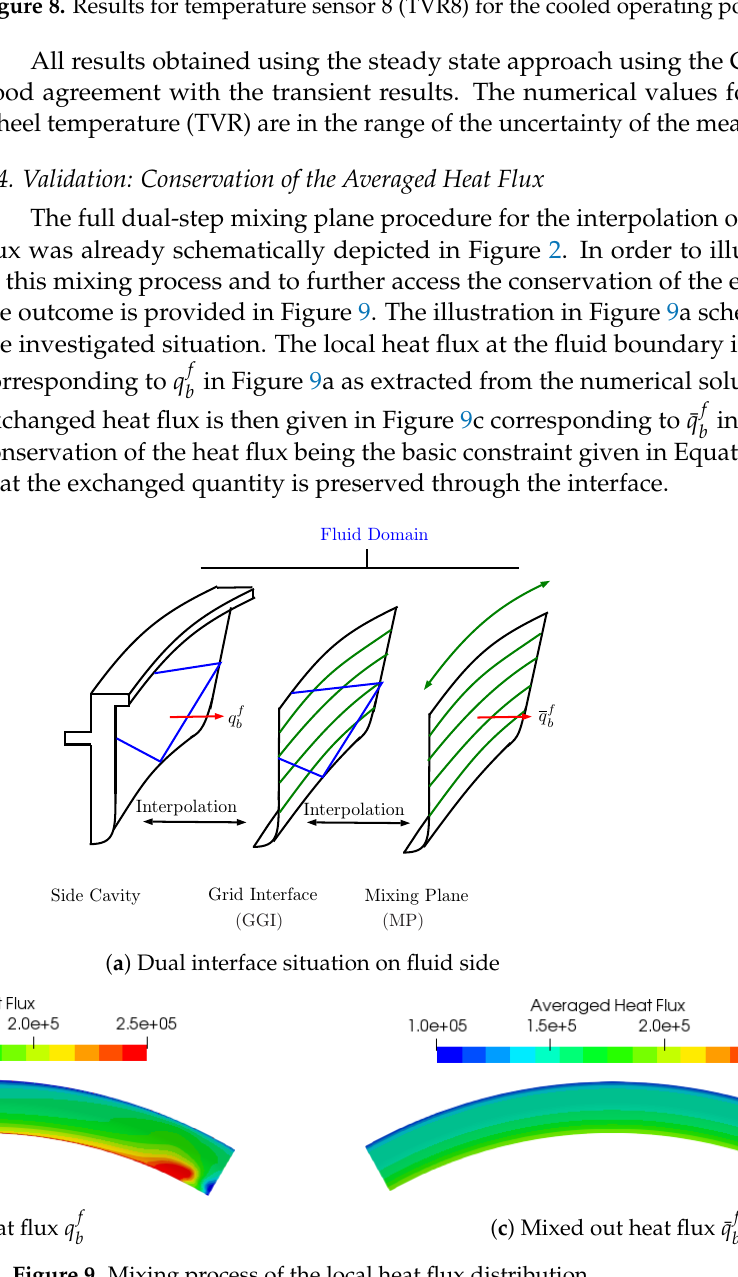
Figure 9. Mixing process of the local heat flux